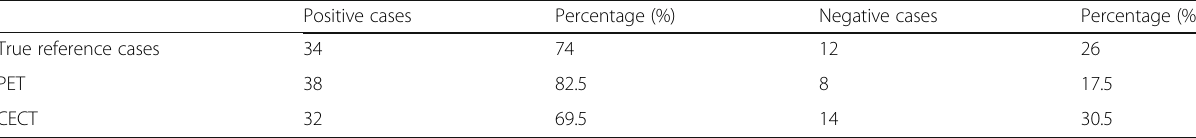
Table 2 Correlation between positive and negative results in true, PET, and CECT study